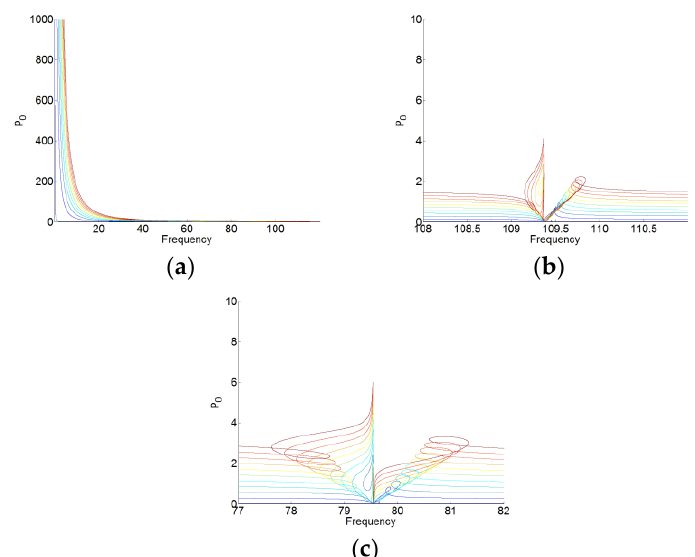
Figure 10. ( a ) Responses of 𝑝 0 (𝑡) for 𝐹 1 = [0.01:2:20.01] . ( b , c ) are the zooms of ( a ) around two resonant frequencies of the cavity.